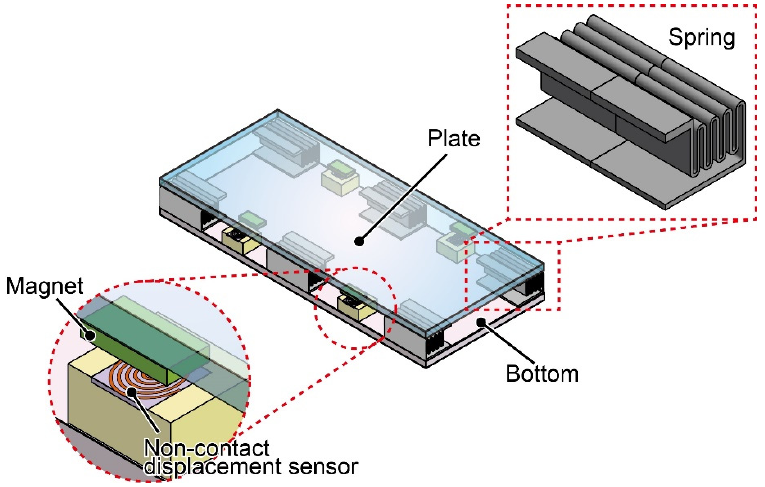
Figure 1. Schematic image of the force plate. The force plate is composed of mechanical springs and noncontact displacement sensor elements using a planar coil.